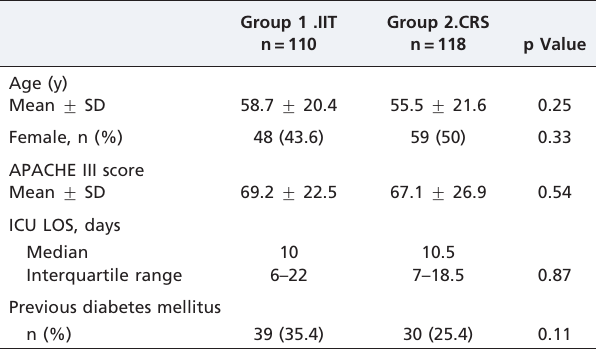
Table 1 - Main patients’ characteristics.